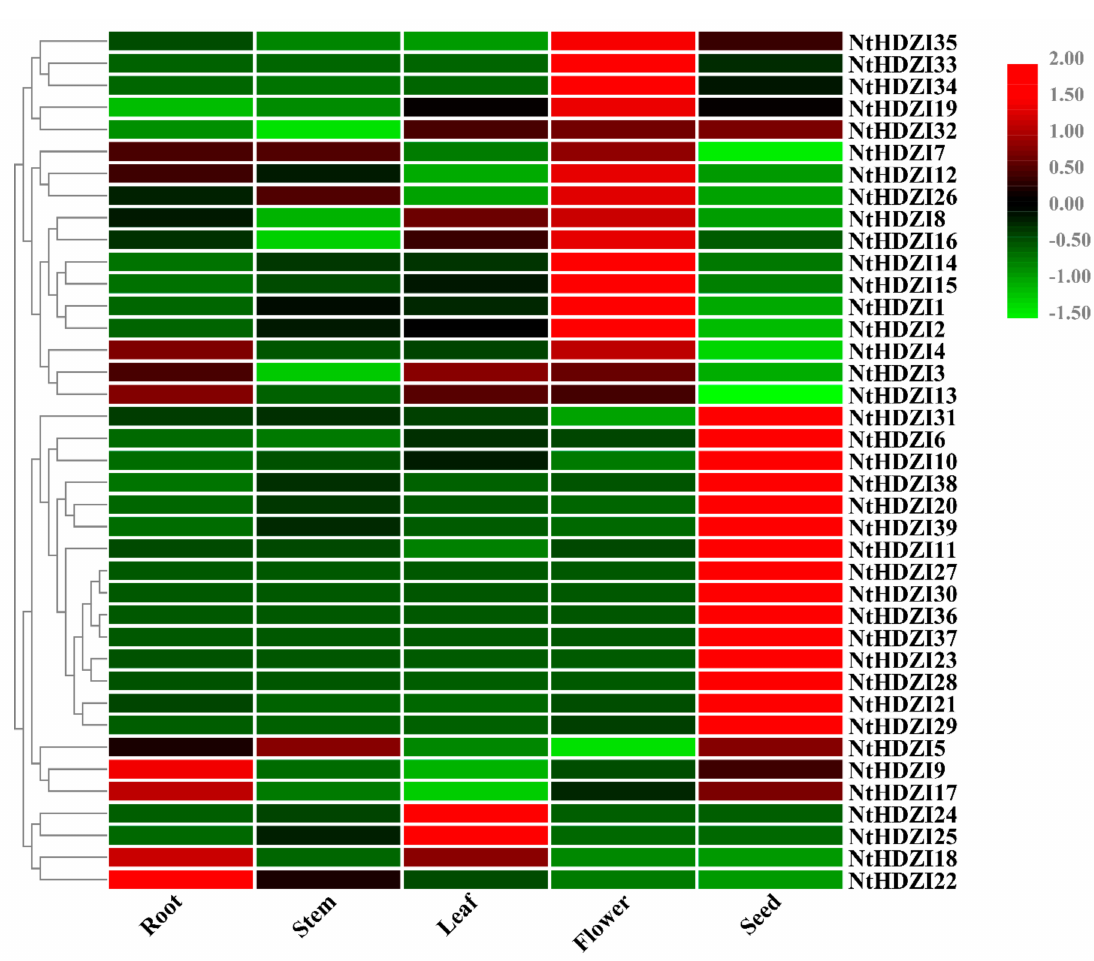
Figure 5. Relative expression levels of NtHDZI genes in various tissues. The roots, stems, leaves, flowers, and seeds were collected from the N. tabacum plants. All of the expression levels of the NtHDZI genes were normalized by the expression levels of NtEF1 α . The 2 − ∆∆ CT method was used to be an evaluation of the relative expression. The heat map was drawn in row scale-transformed expression values. Red or green colors represent the di ff erence in expression levels in each sample,